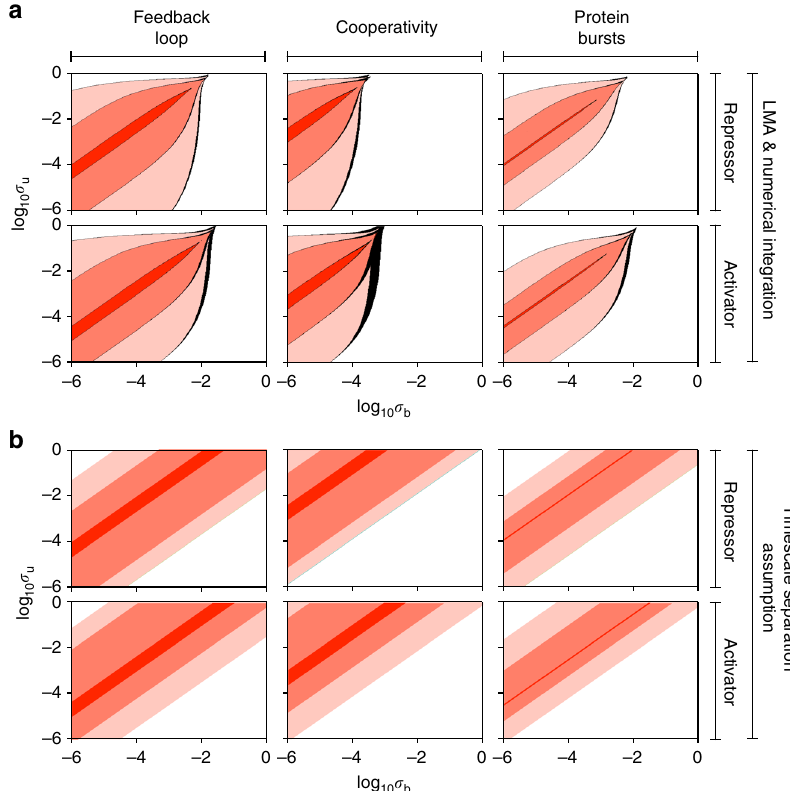
Fig. 9 Stochastic bifurcation diagram for non-oscillatory feedback loops. a The red shaded areas denote the regions of parameter space where the steady- state distribution of protein numbers is bimodal, the white areas shows the regions where the distribution is unimodal and the black areas show regions where the LMA and direct numerical integration of the master equations disagree on the number of modes of the distribution. The black regions are small and thus verify the accuracy of the LMA. The shade of red indicates the difference between gene expression in the two promoter states, where a lighter shade indicates a larger difference. Speci fi cally from inside to outside, the dark red corresponds to ρ u = 40, ρ b = 25 (repressor) and ρ u = 25, ρ b = 40 (activator), the medium red corresponds to ρ u = 50, ρ b = 25 (repressor) and ρ u = 25, ρ b = 50 (activator), and the light red corresponds to ρ u = 60, ρ b = 25 (repressor) and ρ u = 25, ρ b = 60 (activator). The cooperativity order was cp = 2 for the feedback loop with cooperativity and the mean protein bursts size was b = 2 for the feedback loop with bursting. Generally the region of parameter space where bimodality is present is decreased by cooperativity and by bursting but is almost unaffected by the type of feedback (activating or repressing). b This is the same as a except that the number of modes of the steady- state distribution of protein numbers is calculated using a method in the literature which assumes timescale separation, i.e. slow promoter switching 12 . While this method captures the salient features of the bifurcation diagrams in a it also signi fi cantly over-estimates the extent of bimodality and